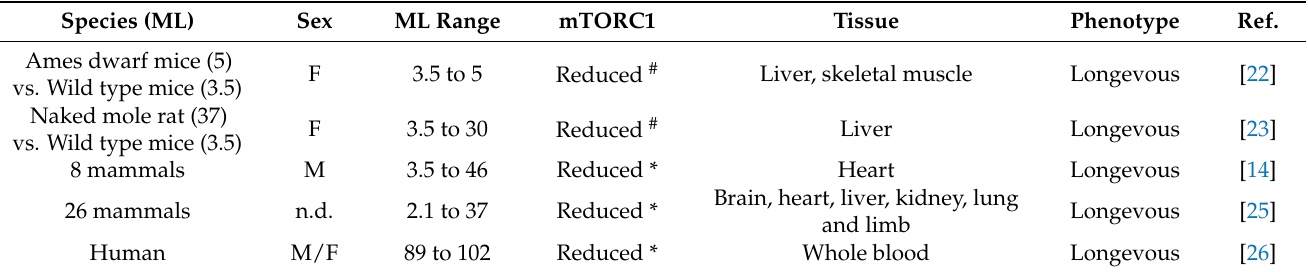
Table 1. Relationship between mTOR and maximum longevity (ML) in basal conditions: interspecies studies. Increased or reduced mTOR content can refer to transcript content, gene expression, protein content, protein phosphorylation, or activity after insulin stimulation. Letters refer to: maximum longevity (ML), in years; female (F); male (M); not determined (n.d.). Symbols refer to: * Studies in which mTORC1 itself expression, content or phosphorylation was evaluated; # Studies in which mTORC1 itself was not evaluated but its upstream or downstream effectors